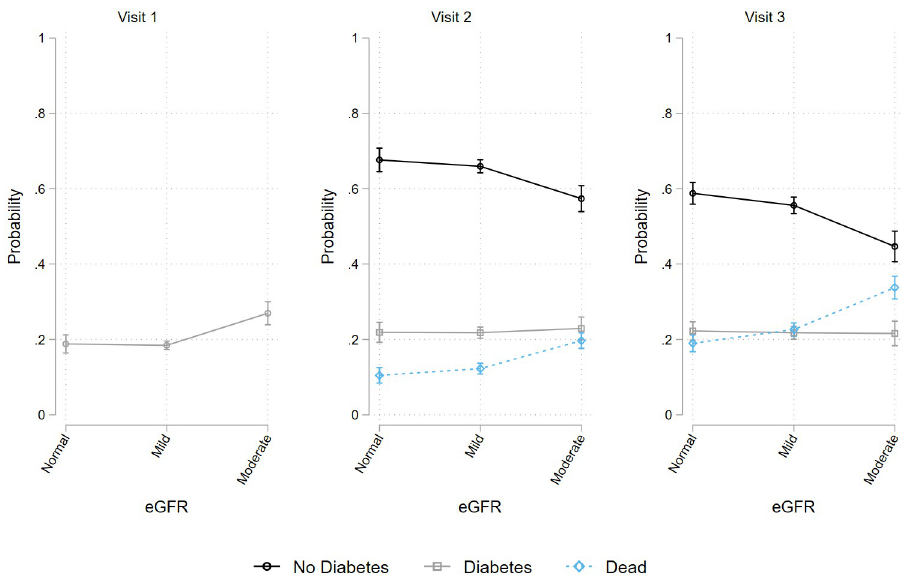
Fig 2. Prevalence of (marginal probability and 95% confidence interval) no diabetes, diabetes, and death status at visit 1, visit 2, and visit 3 by eGFR.